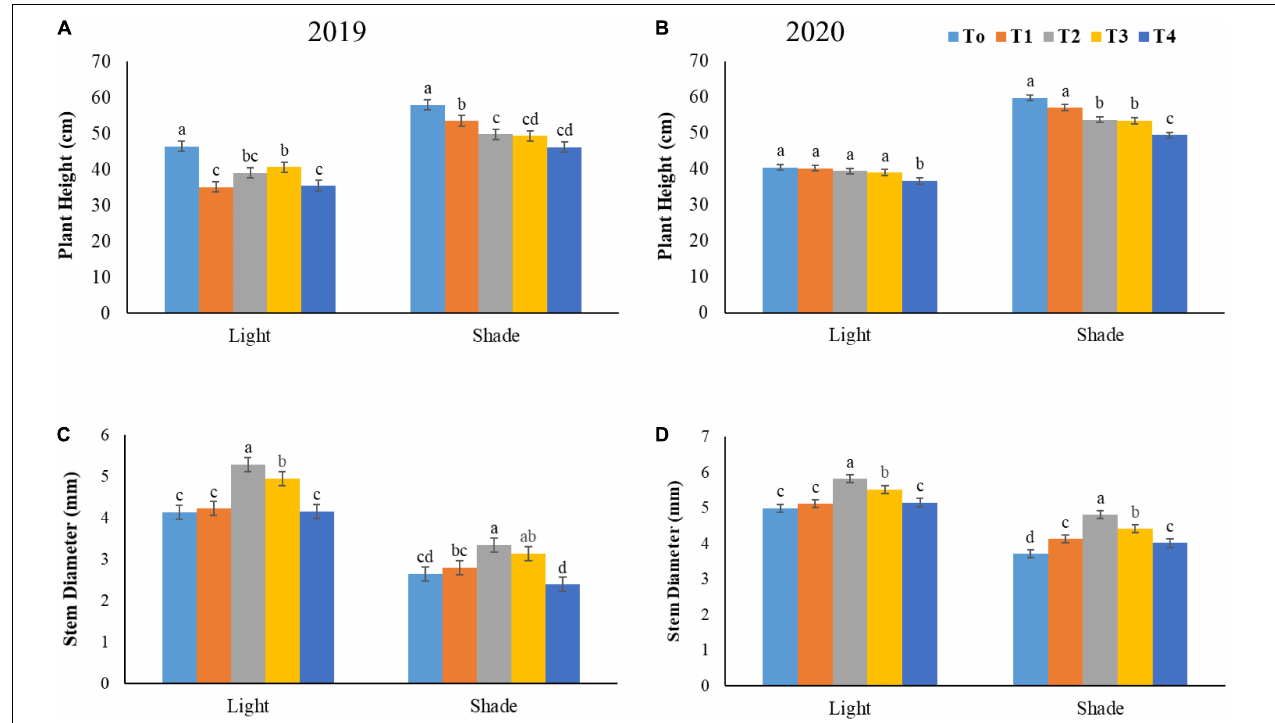
FIGURE 4 | Impact of different NH 4 + /NO 3 − ratios on plant height (A,B) , and stem diameter (C,D) under light and shade. Different treatment levels T0, T1, T2, T3, and T4 characterize the ratios of NH 4 + /NO 3 − 0/0, 0/100, 25/75, 50/50, and 75/25, respectively. All of the results are the mean of three replications. The bars represent the ± SD (standard deviation). A significant difference ( ∗ p < 0.05) between treatments is shown by different lowercase letters above